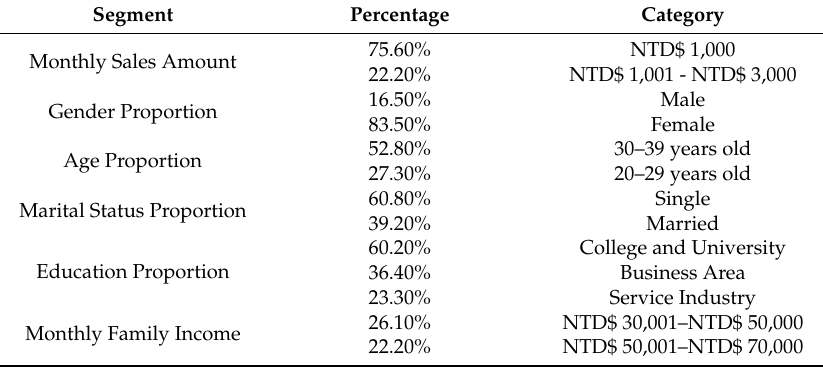
Table 1. Target customer analysis for Essential Oil and Aromatherapy